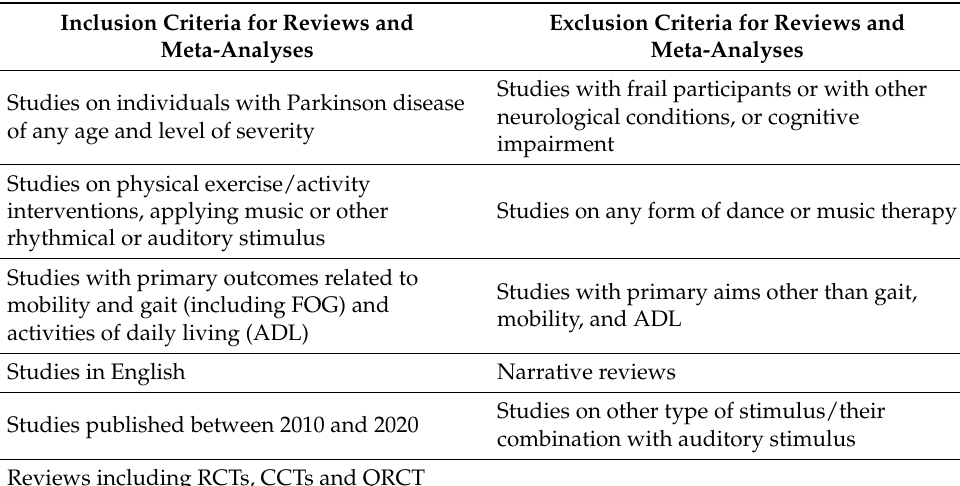
Table 1. Inclusion and exclusion criteria for reviews and meta-analyses of